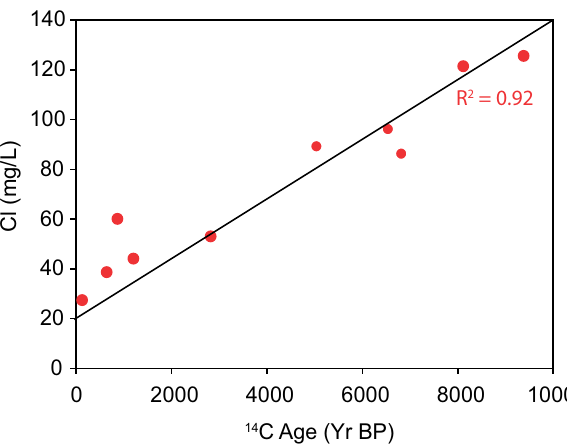
Figure 9. 14 C age vs. Cl. 14 C ages are taken from the calcite cor- rected ages in Table